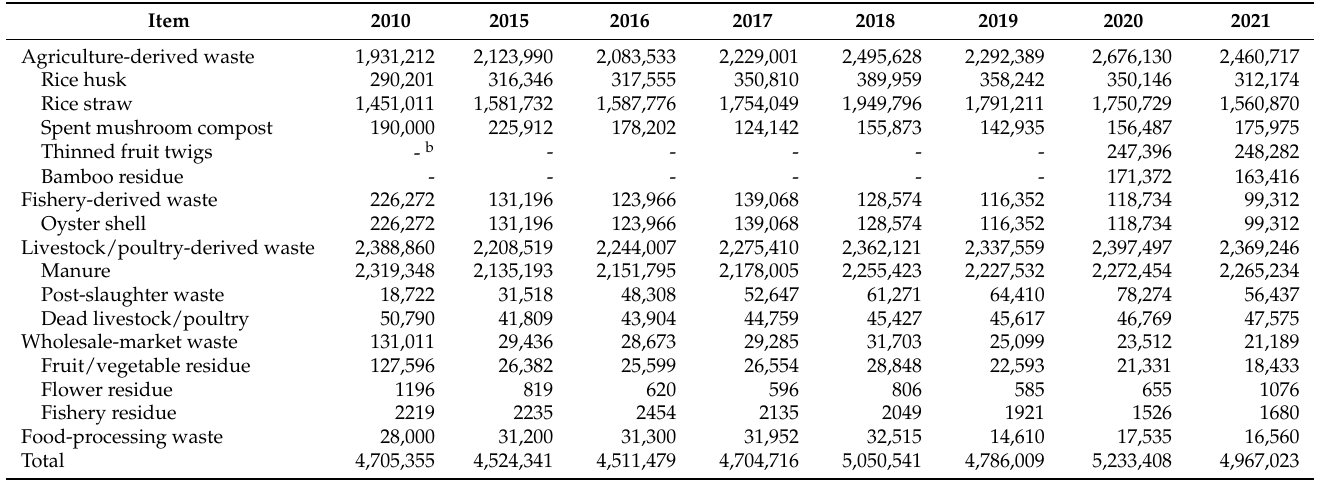
Table 1. Statistics of biological waste generation from the agricultural sector in Taiwan a